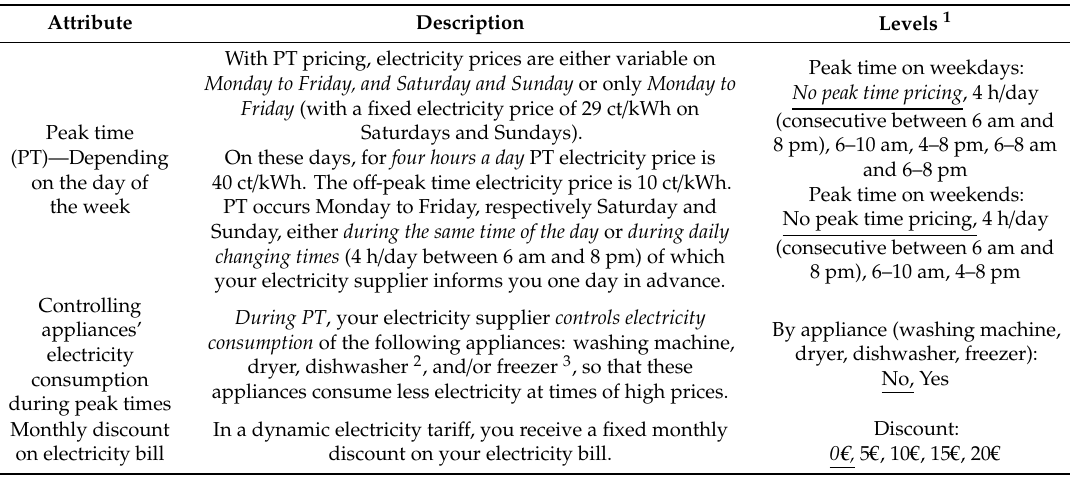
Table 1. Attributes, their description, and their